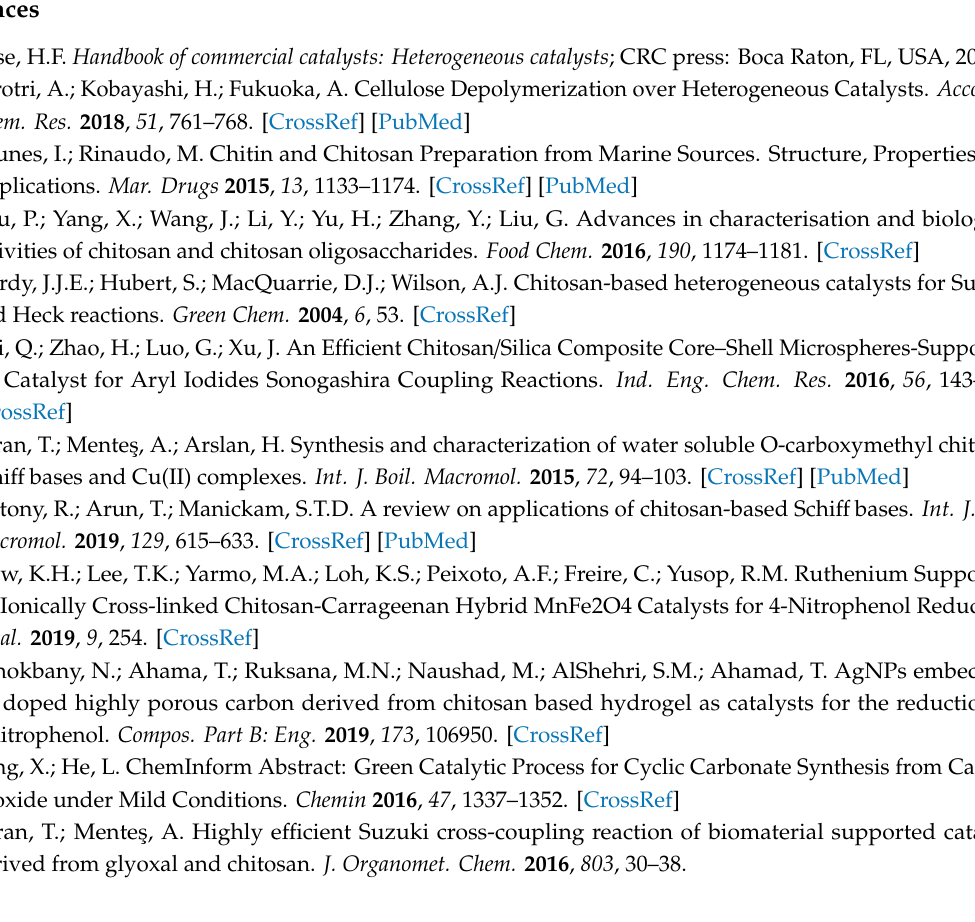
Table S1: The content of N, C, H, O of chitosan microspheres (CS) and of modified chitosan microspheres (CSM); Table S2: The adsorption of the CS and CSM; Table S3: Swelling capability of CSM at di ff erent pH value; Figure S1: Diameter distribution of copper nanoparticles (CSM@Cu 0